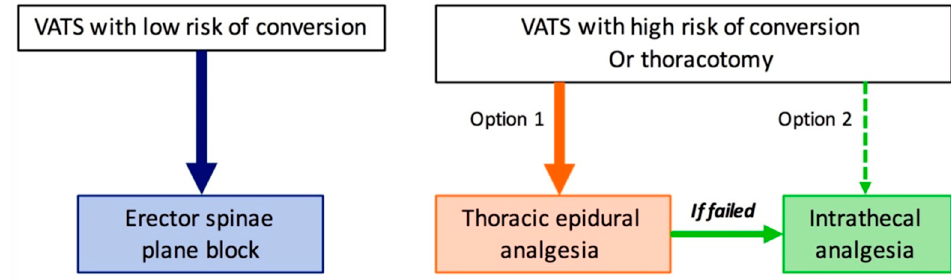
Figure 1. Choice procedure for the regional anesthesia technique to use in lung surgery at Angers University Hospital, France.